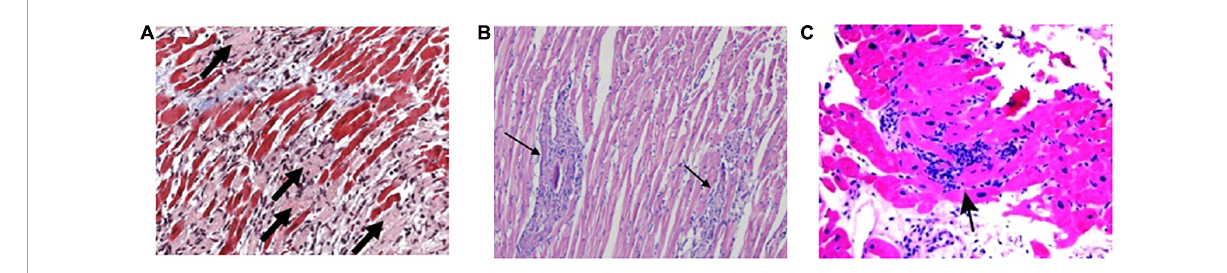
FIGURE5 The main characteristics of histology in VMC. (A) Active myocarditis is characterized by an inflammatory cellular infiltrate with numerous necrotic myocytes. (B) Representative histopathology in a borderline myocarditis group. The inflammatory region is showed with several large foci of cellular infiltrations. (C) Diffuse lymphocytic infiltration of myocardium is described as lymphocytic, eosinophilic, or granulomatous in endomyocardial biopsy specimens. VMC, viral